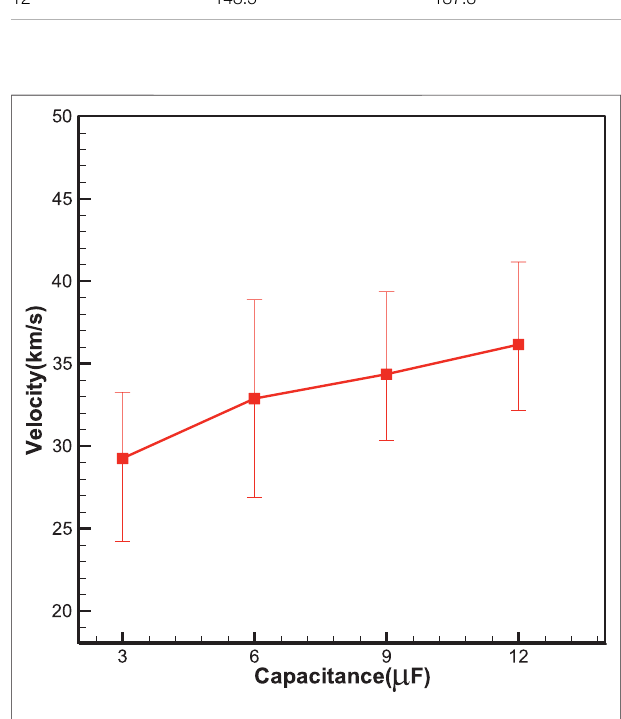
FIGURE 7 | APPT plasma movement velocities at different capacitances.